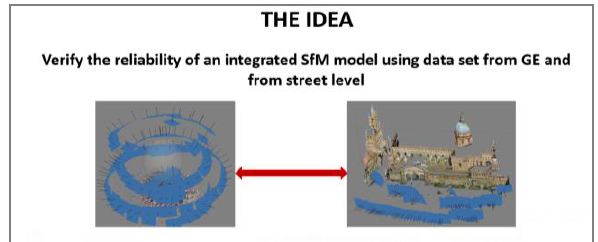
Figure 2. The idea: verify the reliability of the integrated project In this paper will be present a case study: the Cathedral of Palermo. (Fig. 3)